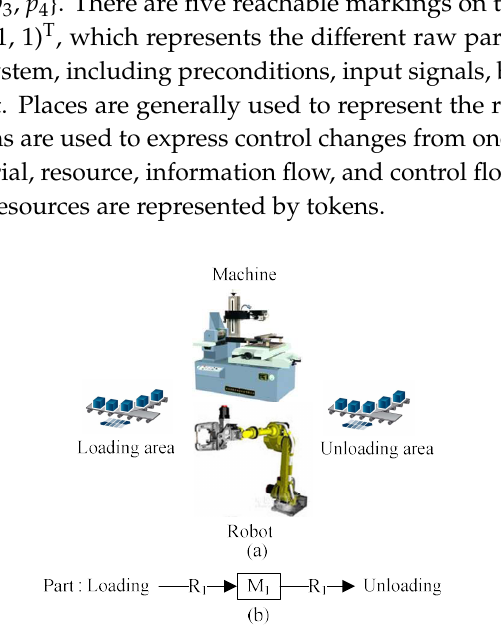
Figure 2. A system of ( S 2 P) (simple sequential process) (S 3 PR) net of the AMS. 2.2. Reconfigurable S 3 PR Net This section presents definitions and theorems in the reconfigurable S 3 PR nets, which are originally proposed by [34, 35, 39]. Definition 20: Let N = ({ p 0 } ∪ P A ∪ P R , T, F, W, M o , K ) be a finite-capacity S 3 PR, where p 0 , P A , P R , T, F, W, and M o are defined in Definitions 1–6. K: P C → IN is the function of capacity that assigns to each place p the maximal number of tokens K(p) . Definition 21 : Let (N i , M i ) be two S 3 PR nets with N i = ( P Ci , T i , F i , W i , M i , K i ), i= 1, 2. N 1 and N 2 are called morphism nets if there exists a bijection Ψ: N 1 → N 2 , Ψ = (Ψ PC : P C1 → P C2 , Ψ T : T 1 → T 2 ) such that for all a , b ∈ P C1 ∪ T 1 , F 1 ( a , b ) ∈ N 1 = F 2 ( Ψ ( a ), Ψ ( b )) ∈ N 2 , and for all p ∈ P C1 , M 1 ( p ) ≤ M 2 ( Ψ PC ( p )). Definition 22 : Let (N i , M i ) be two S 3 PR nets with N i = ( P Ci , T i , F i , W i , M i , K i ), i = 1, 2. N 1 is called the full subnet of N 2 if there exists an injection function that maps places to places and transitions to